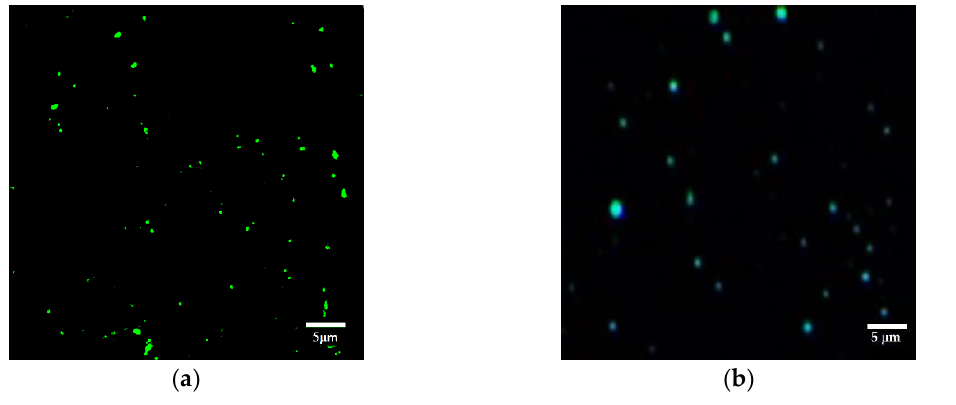
Figure 3. Confocal images of ( a ) Catalyst I ; ( b ) Catalyst II .